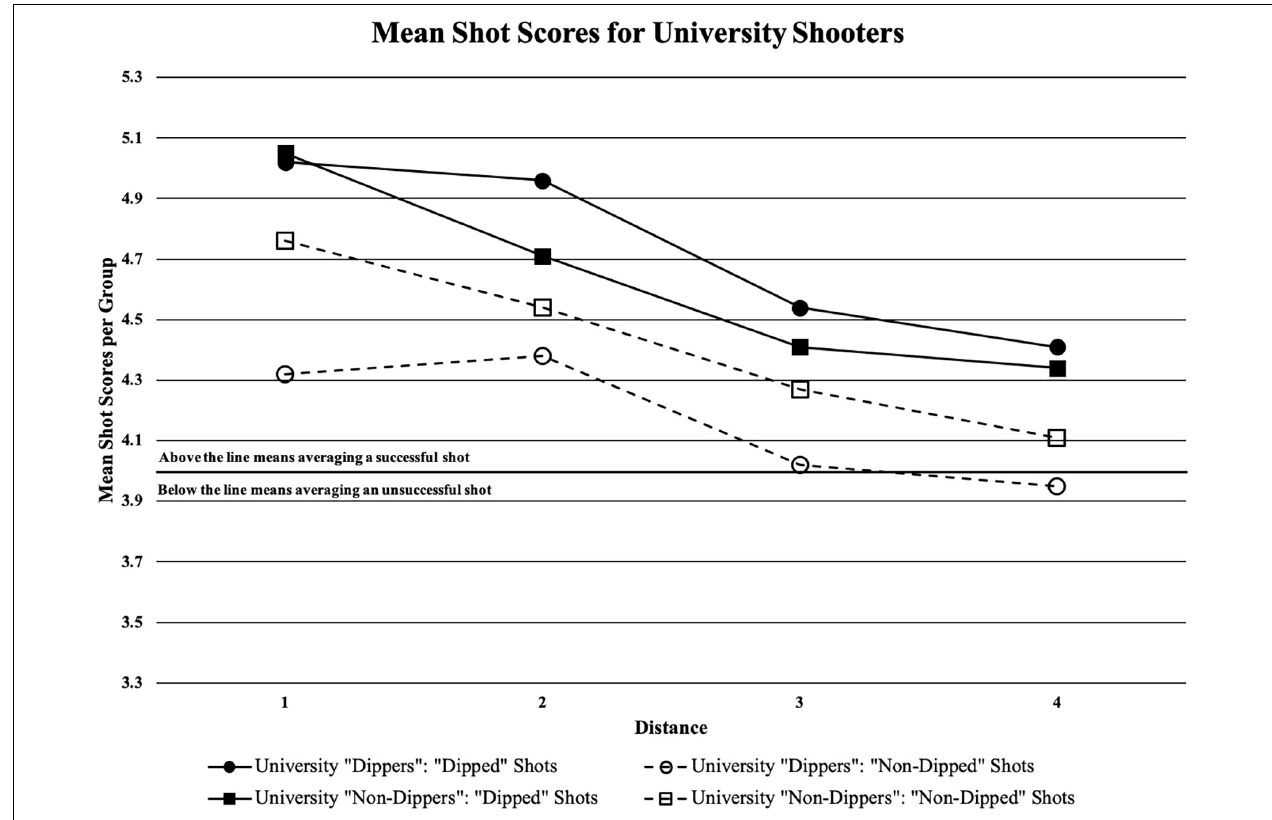
FIGURE 5 | Mean shot quality scores from each of the two shooter types (“dipped” or “non-dipped”) university players at each of the four distances; black horizontal line is the cut-off point for when a certain group would be averaging a successful shot (if above the line) or averaging an unsuccessful shot (if below the